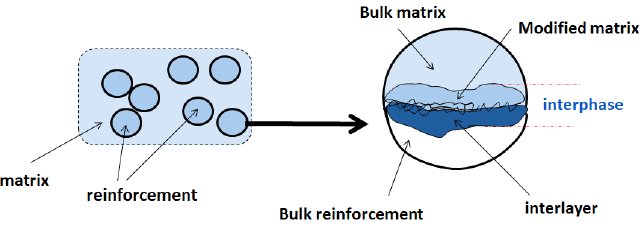
Figure 1. Representation of the interphase between matrix and fillers.